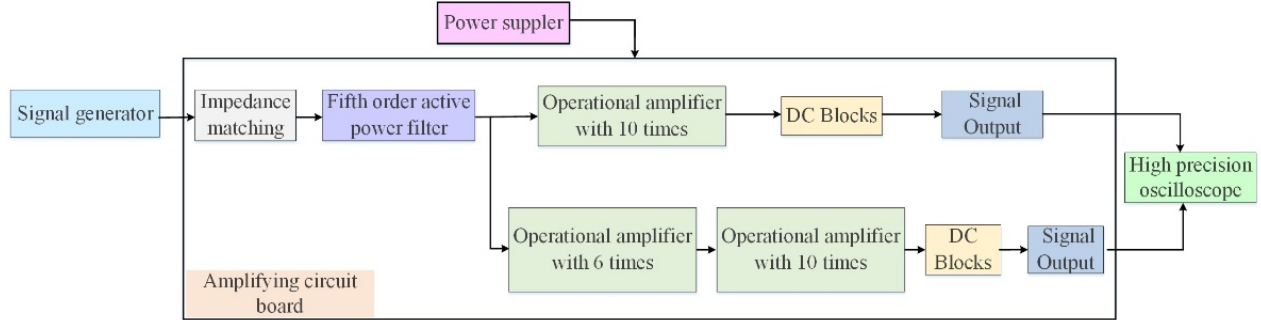
Figure 12. ( a ) Simulation data of output peak voltage of the optimized ACB changing with input power and its fitting straight line. ( b ) Voltage differences between simulation data and fitting straight line in Figure 12a. ( c ) Simulation data of output integral voltage of the optimized ACB changing with input power and its fitting straight line. ( d ) Integral voltage differences between simulation data and fitting straight line in Figure 12c.